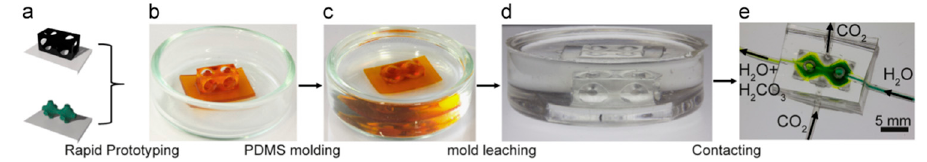
Figure 21. Step-by-step fabrication of a tricontinuous PDMS membrane based on Schwarz-P geometry, adapted from [38] .